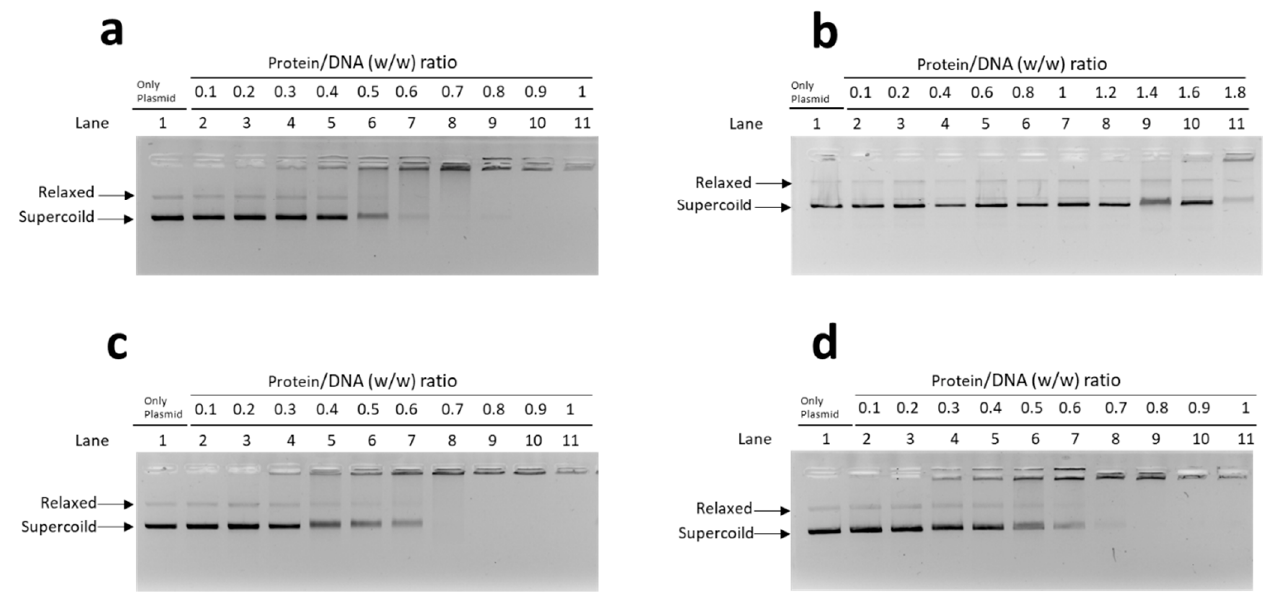
Figure 3. EMSA with: ( a ) PLs from unexposed mussels; ( b ) PLs extracted from mussels exposed to 1 nM chromium (VI); ( c ) PLs extracted from mussels exposed to 10 nM chromium (VI); ( d ) PLs extracted from mussels exposed to 100 nM chromium (VI). Only plasmid denotes plasmid DNA without proteins; relaxed = relaxed DNA plasmid; supercoiled = supercoiled DNA plasmid. In the assay conducted with PLs extracted from unexposed mussels, as shown in panel a, the DNA saturation was reached at a wt/wt Protein/DNA ratio of about 0.8. A